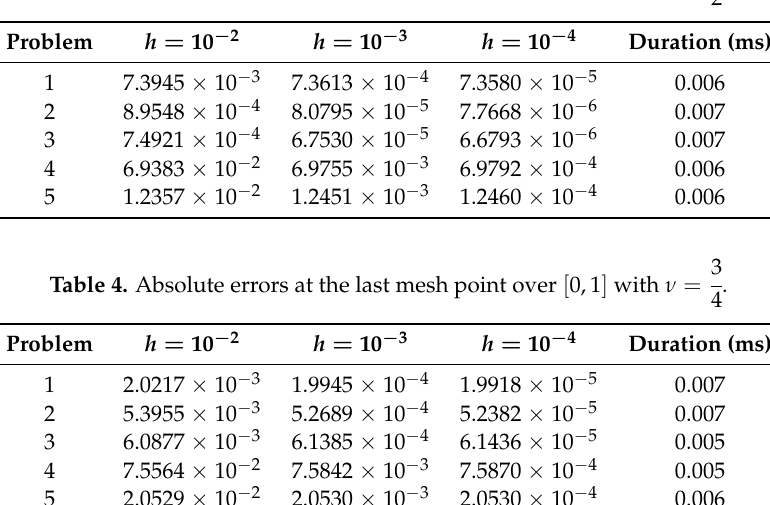
Table 3. Absolute errors at the last mesh point over [ 0,1 ] with ν =